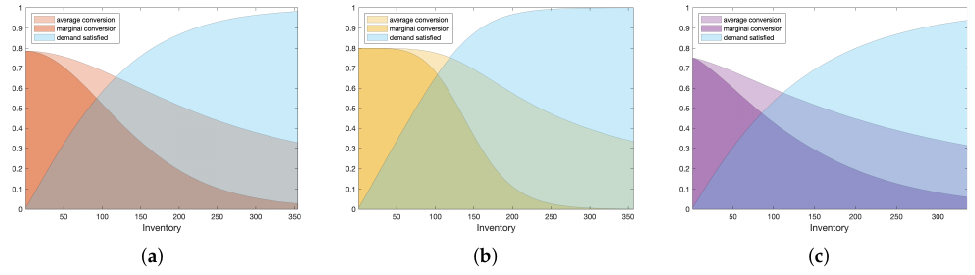
Figure 5. The curves of average conversion rate, marginal conversion rate and demand satisfied proportion related to inventory for the belts dataset by cluster. ( a ) Cluster 1 (mean D = 118). ( b ) Cluster 2 (mean D = 119). ( c ) Cluster 3 (mean D =